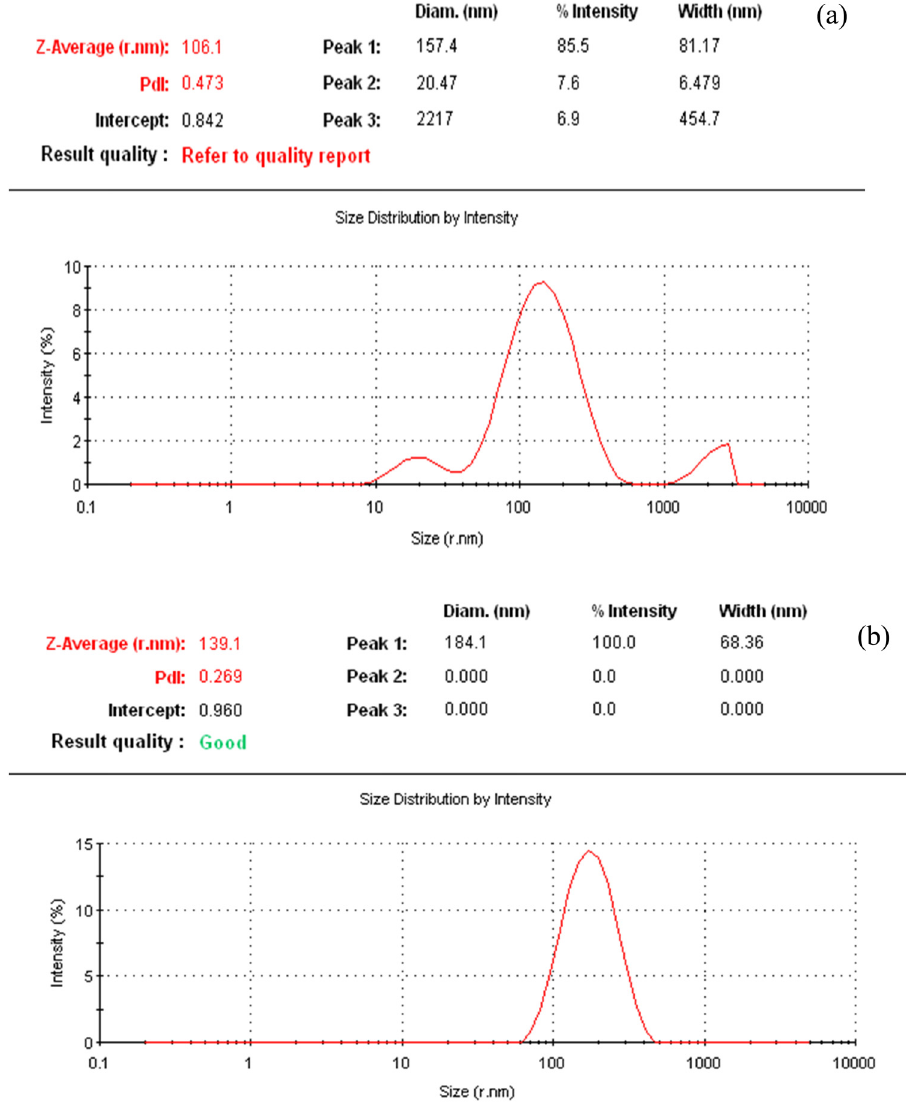
Figure 3: Zetasizer measurement of the average size of ( a ) Ag/Au nanocomposite and ( b ) ZnONPs synthesized by the extract of